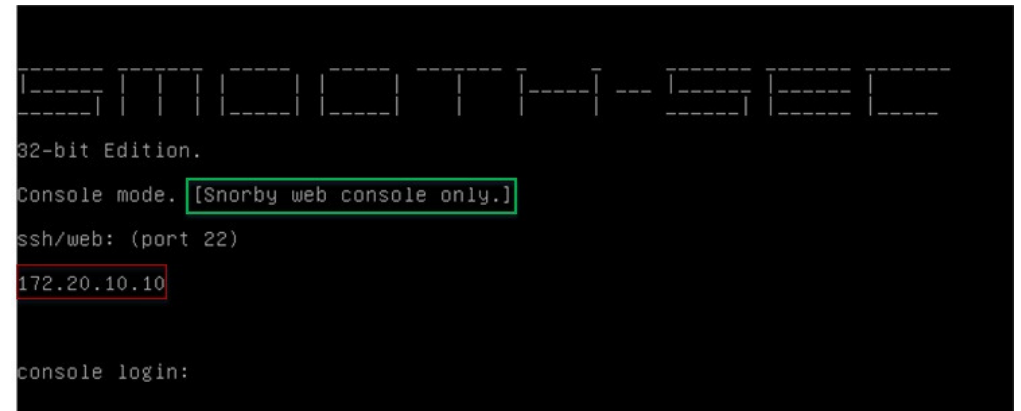
Fig. 11: Smooth-sec installed as console